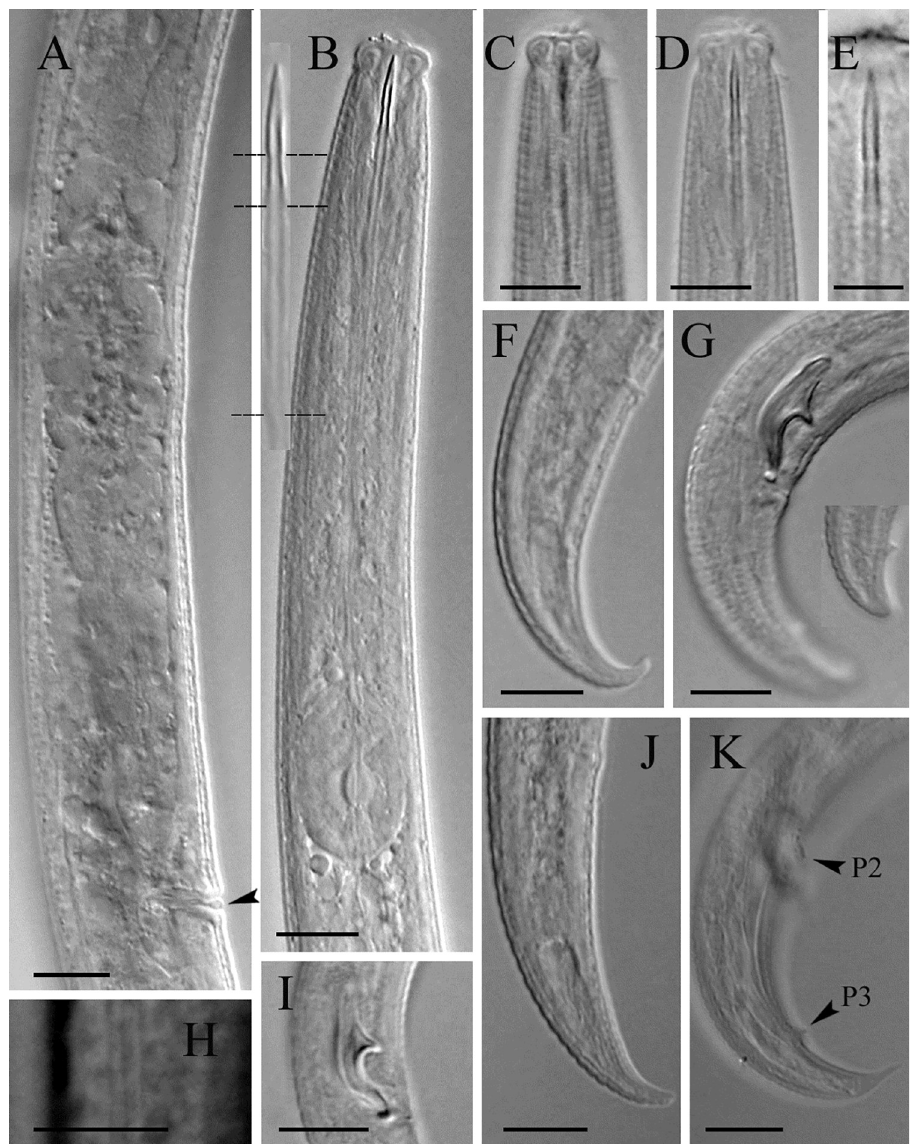
Fig 2. Light microphotographs of Ektaphelenchus kanzakii n. sp. A: Part of female reproductive system (epiptygma- like differentiation in vulva is visible; arrowhead), B: Part of pharynx (inset: Stylet in detail, ca. 20 μ m long), C&D: Anterior end, E: Conus and middle part of stylet in high contrast, F&J: Female posterior body end, G&K: Male posterior body end, H: Lateral lines, I: Spicules. (All scale bars = 10 μ m, except the inset in plate B, its conus 7 μ